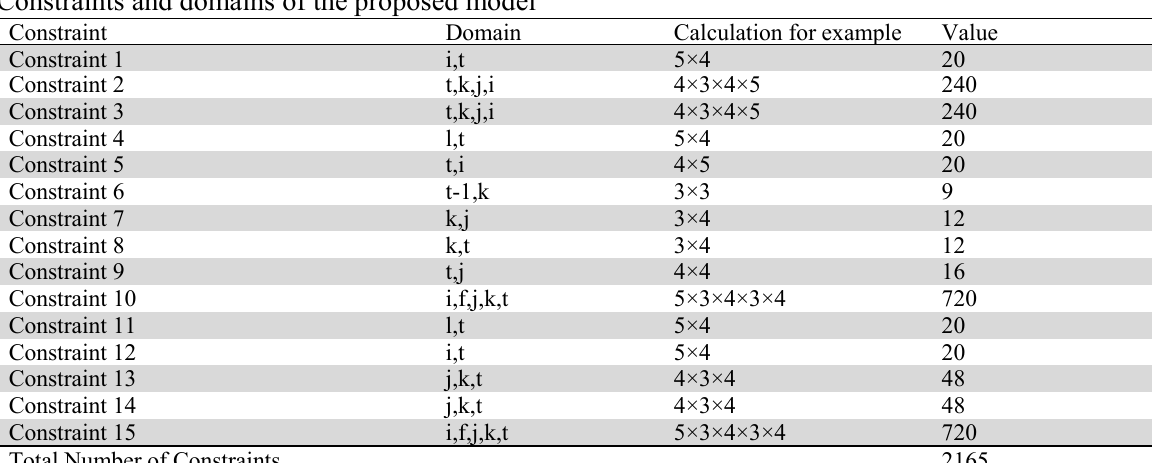
Constraints and domains of the proposed